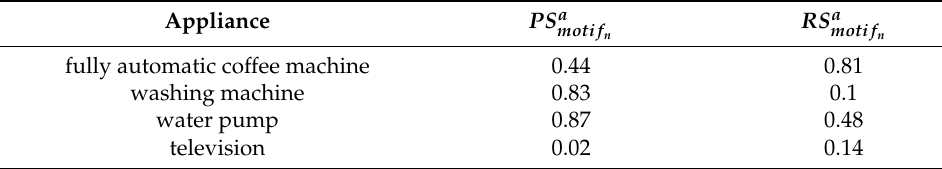
and RS a for four exemplary motif n motif n